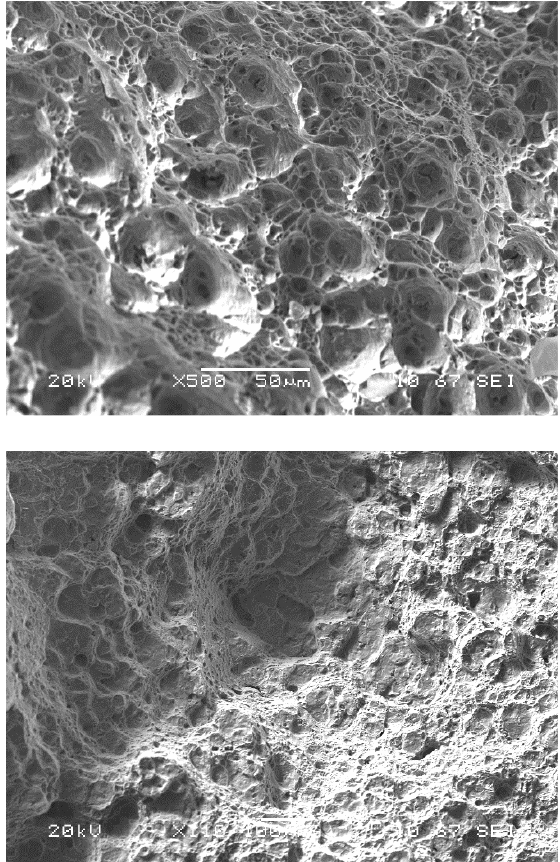
Figure 16. SEM pictures for “R2” under ELCF, show rough dimpled surfaces created by microvoids growth and coalescence with no signs of striations due to ELCF. The upper and lower images show a magnification of X450 and X110, respectively.